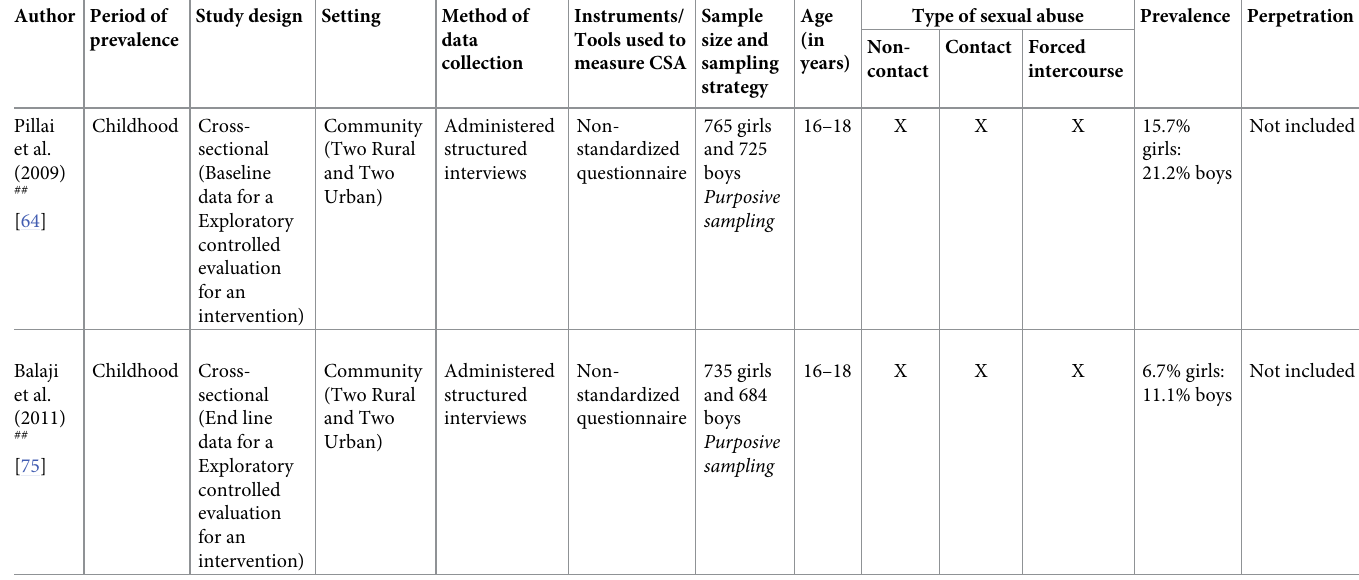
Table 5. Characteristics of quantitative and mixed-method studies included in the review with school/college, clinical, and community sample. Author Period of Study design prevalence